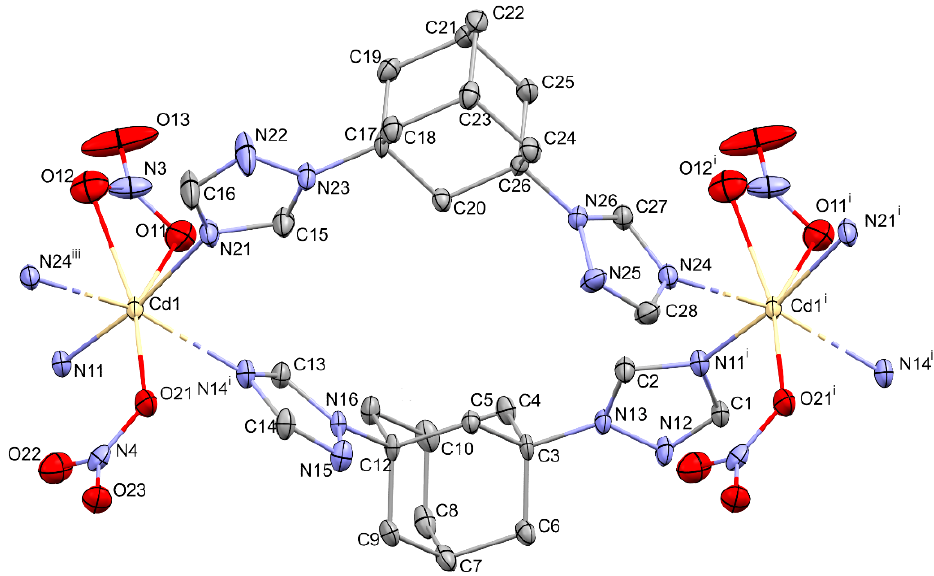
Figure 3. Fragment of crystal structure of coordination polymer 2 showing thermal ellipsoids (at 50% probability level) and labels for non-hydrogen atoms. Hydrogen atoms are omitted for clarity. Symmetry operations: i ( x + 1, y , z) ; ii (2 + x , y , z) ; iii (−1 + x , y , z ).